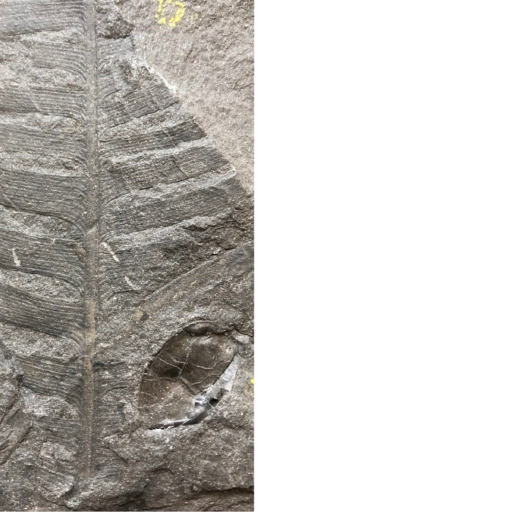
Figure 18. Plant fragment from the Oppenau Basin, S-Germany: Pterophyllum blechnoides , last-order pinna with parallel-veined pinnae, MfNC F10227, scale bar: 5 mm. Souss Basin,